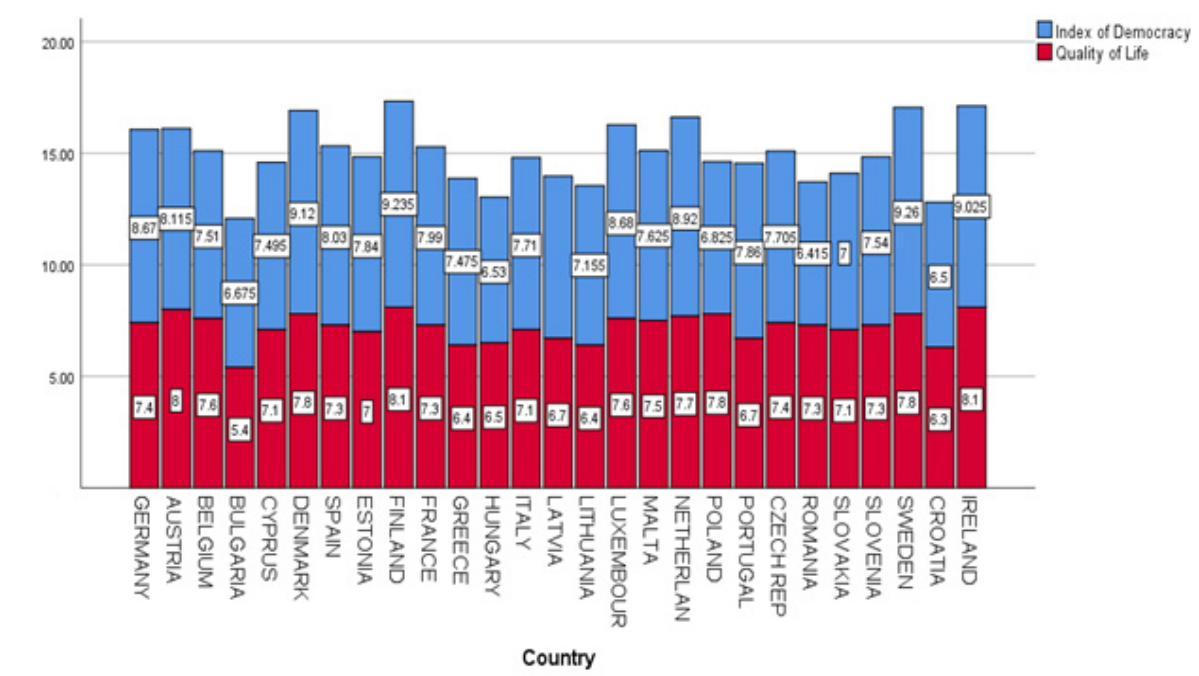
Figure 6. Quality of life and Democracy Index in EU-27. Average during the period 2020–2022. Sources of data: Eurostat, Quality of Life: https://ec.europa.eu/eurostat/cache/infographs/qol/index_en.html (accessed on 15 August 2022); The Economist Intelligence Unit, Index of Democracy: https://www.eiu.com/n/campaigns/democracy-index-2021/ (accessed on 6 June 2022).